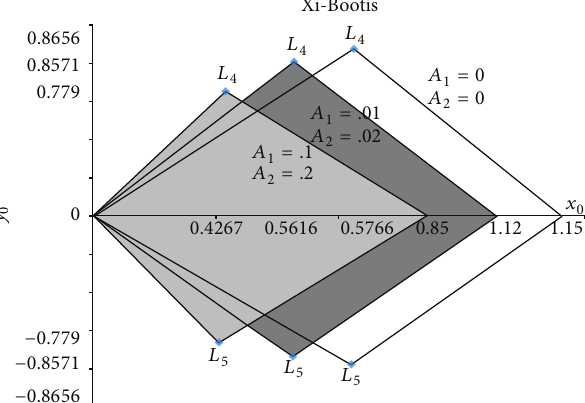
Figure 5: Location of triangular points for